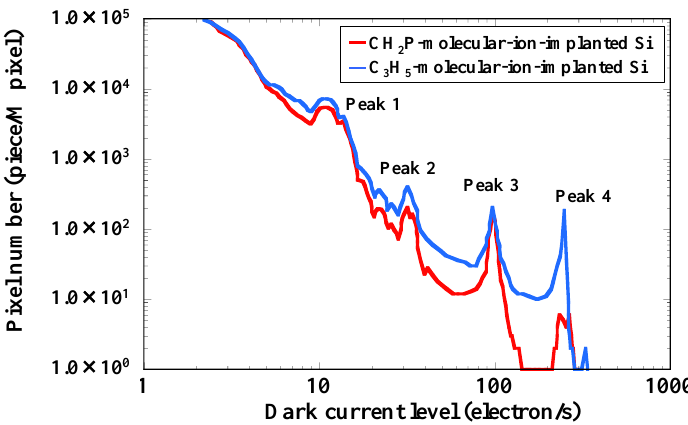
Figure 3. Dark current histogram obtained by DCS at 60 ◦ C for CMOS image sensors fabricated with CH 2 P- and C 3 H 5 -molecular-ion-implanted epitaxial silicon